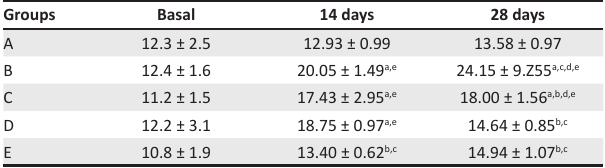
TABLE 5: Effects of Vernonia amygdalina on platelet count (10 3 / µ L) of alloxan- induced diabetic rats. Groups